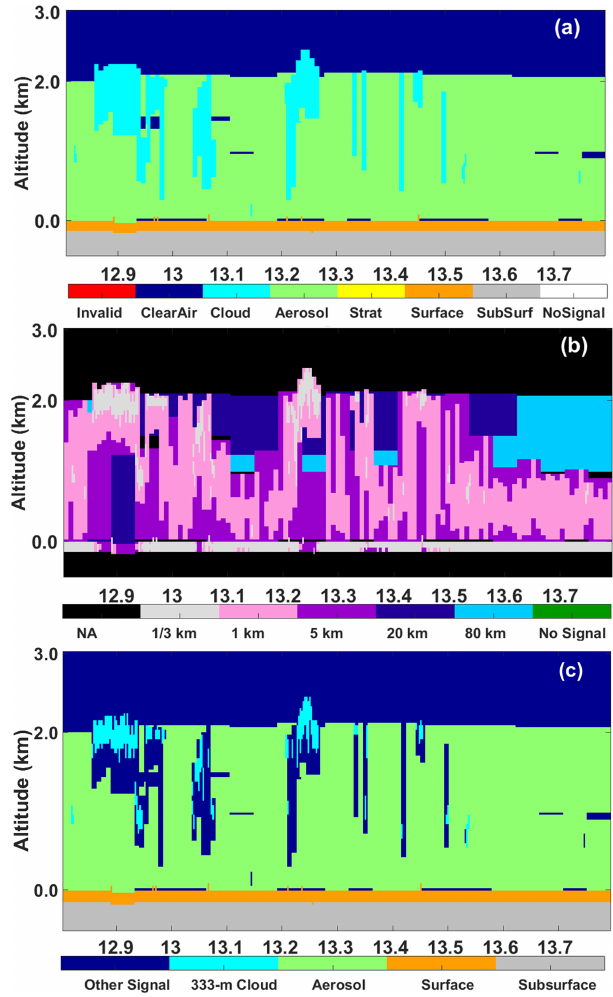
Figure 2. Schematic of CALIPSO low-level cloud feature deter- mination (CALIPSO VFM data at 05:51:17UTC on 3 January 2017). (a) Latitude–altitude distribution of feature type based on CALIPSO VFM feature type parameter; the light blue areas rep- resent the water cloud features. “Strat” is the stratospheric feature; “SubSurf” is the subsurface. (b) Resolution information distribu- tion based on CALIPSO VFM resolution parameter; the gray areas represent the 333m resolution features. (c) The 333m horizontal resolution water cloud distribution combined by panels (a) and (b) ; the light blue areas indicate the 333m horizontal resolution water clouds, the green areas refer to aerosols at any resolution, and the orange area is the